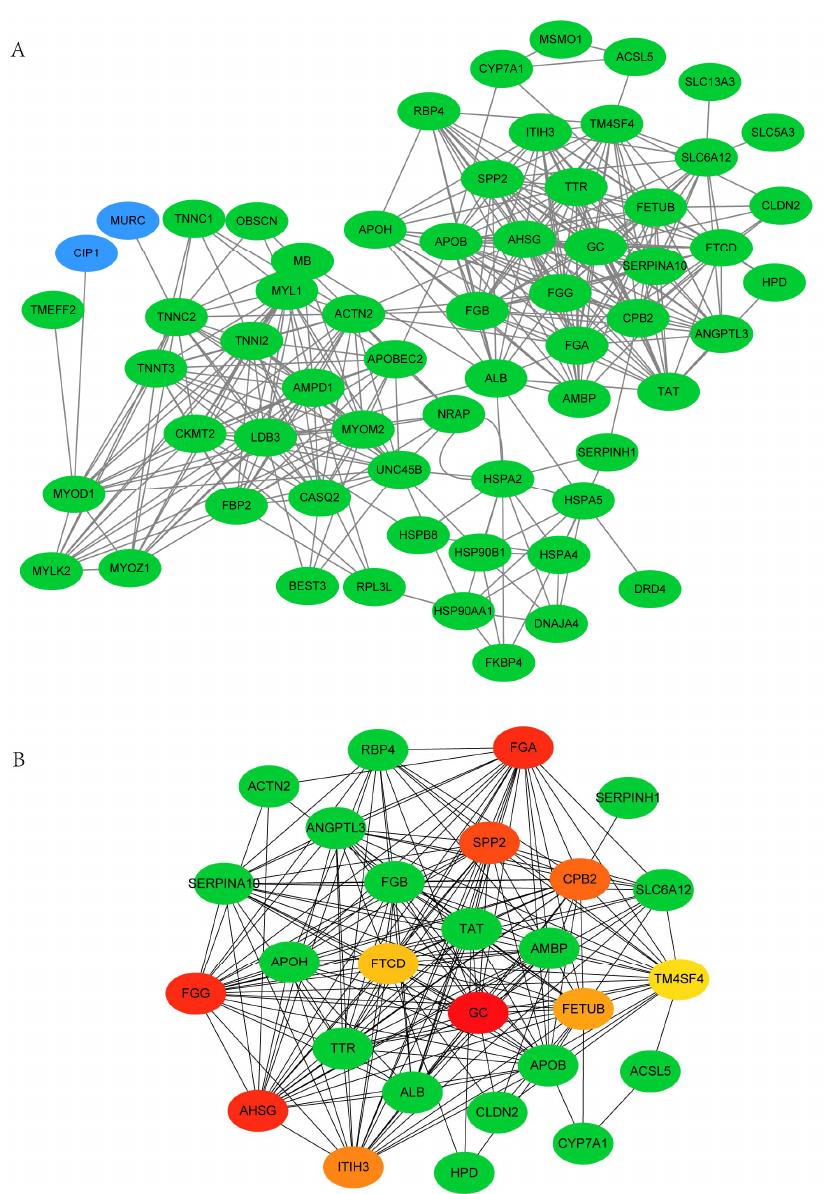
Figure 6. ( A ). PPI network analysis of differentially expressed genes (DEGs) between 66 and 35 weeks. A total of 63 nodes and 368 edges were screened. The green node represents the downregulated DEGs, and the blue one represents the related genes. ( B ). The color of nodes represented the MCC score of each gene. The color ranging from red to green represents high to low rank of DEGs.